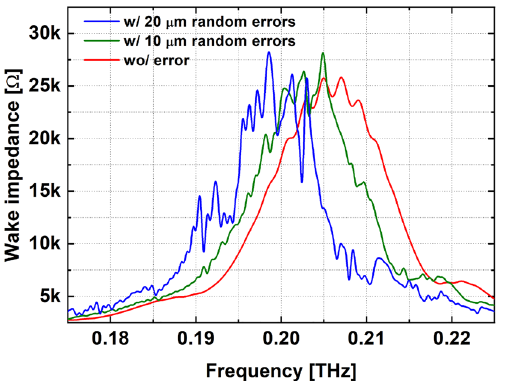
Figure 1. Tolerance simulation by CST particle studio. Machining errors and transverse offsets of each disk are randomly provided within the given range. The reference case (red) shows symmetrical peaks around 0.206 THz. The random errors with 10 µ m (green) and 20 µ m (blue) show shifted and unpredictable spectrums.